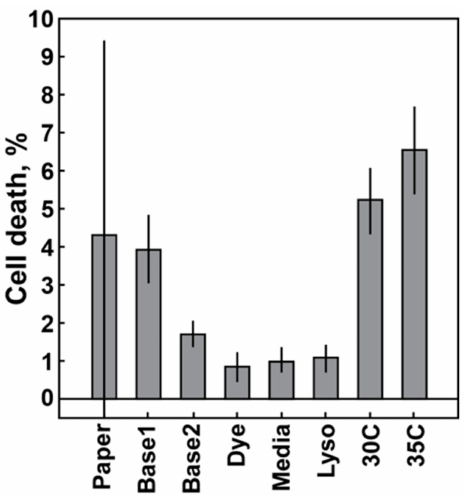
Figure 2. Cell death response of the MSSA Sanger 476 strain at 60 min as a function of the experimental condition. Each column represents an average and standard deviation of multiple replicates for each condition. Column data origin: Paper: data from previously published paper [18]; Base1 and Base2: baseline data acquired during three consecutive weeks with significant change in average response level; Dye: fresh fluorescence stain; Media: fresh cell culture media; Lyso: fresh lysostaphin; 30C,